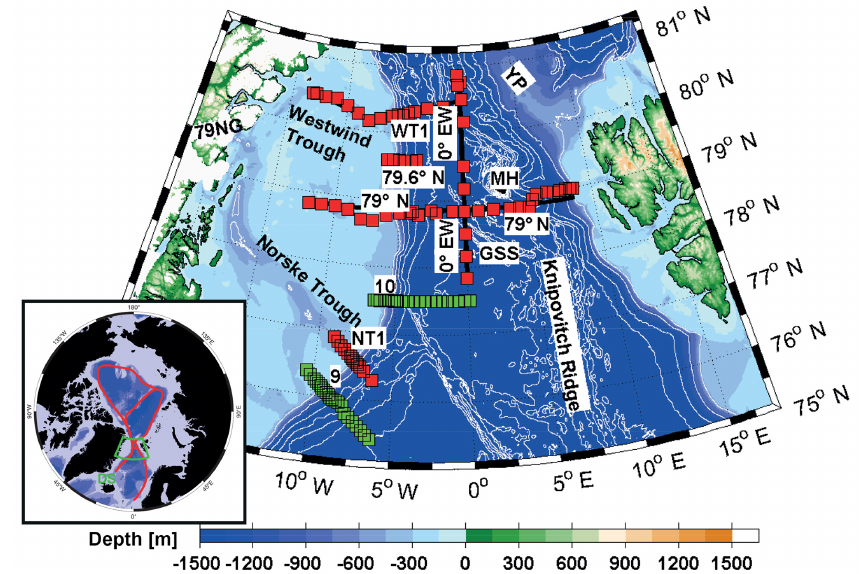
Figure 1. Map of the Fram Strait between east Greenland and Svalbard. The inset shows AW and AAW pathways in the Nordic Seas and Arctic Ocean and the location of Denmark Strait (DS). Station locations are shown as red squares, the interpolated sections as bold black lines. The section names of this study are WT1, 79.6 ◦ N, ∼ 79 ◦ N, NT1, 0 ◦ EW; also shown are sections 9 and 10 of Håvik et al. (2017) in green. The locations of the Norske and Westwind troughs, 79N Glacier (79NG), Yermak Plateau (YP), Knipovitch Ridge, Greenland-Spitsbergen Sill (GSS) and Molloy Hole (MH) are also shown. Bathymetry is from Schaffer et al.